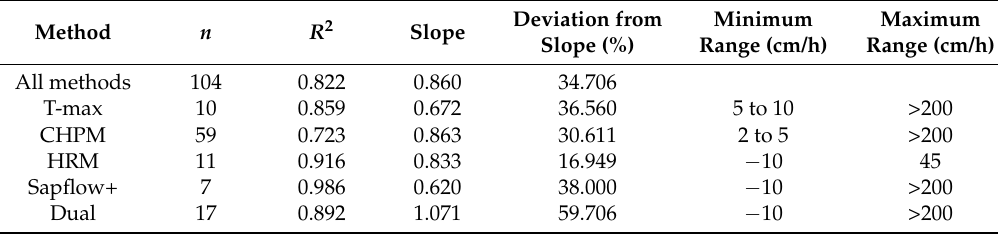
Table 1. A summary of descriptive statistics derived from the meta-analysis of research on the accuracy of HPV methods against an independent measurement of plant water use. Values for R 2 , slope, and deviation from slope are means from the studies compiled in Supplementary